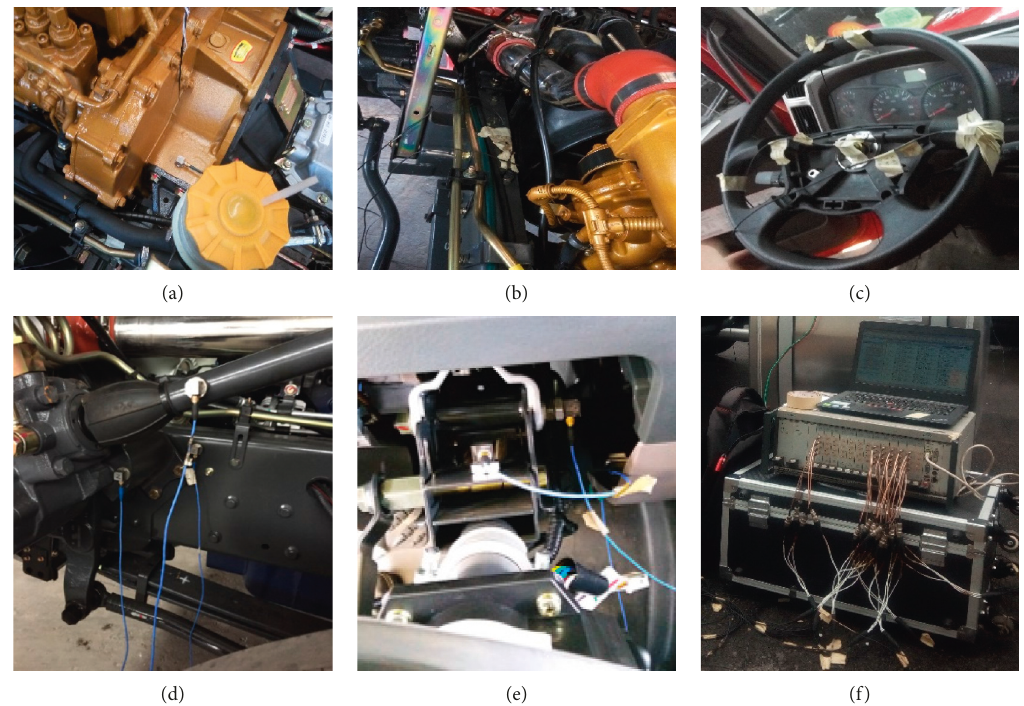
Figure 11: Arrangement of experimental measuring points: (a) engine, (b) frame, (c) steering wheel, (d) steering box and steering box corresponding frame, (e) steering fixed support, and (f) test acquisition equipment.